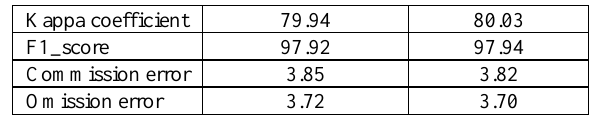
Table 2. Accuracy assessment.